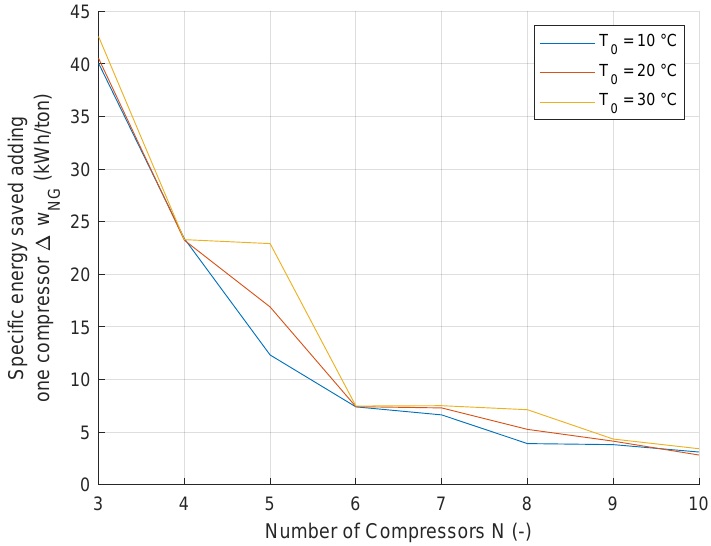
Figure 10. Energy savings gained by adding an extra compressor